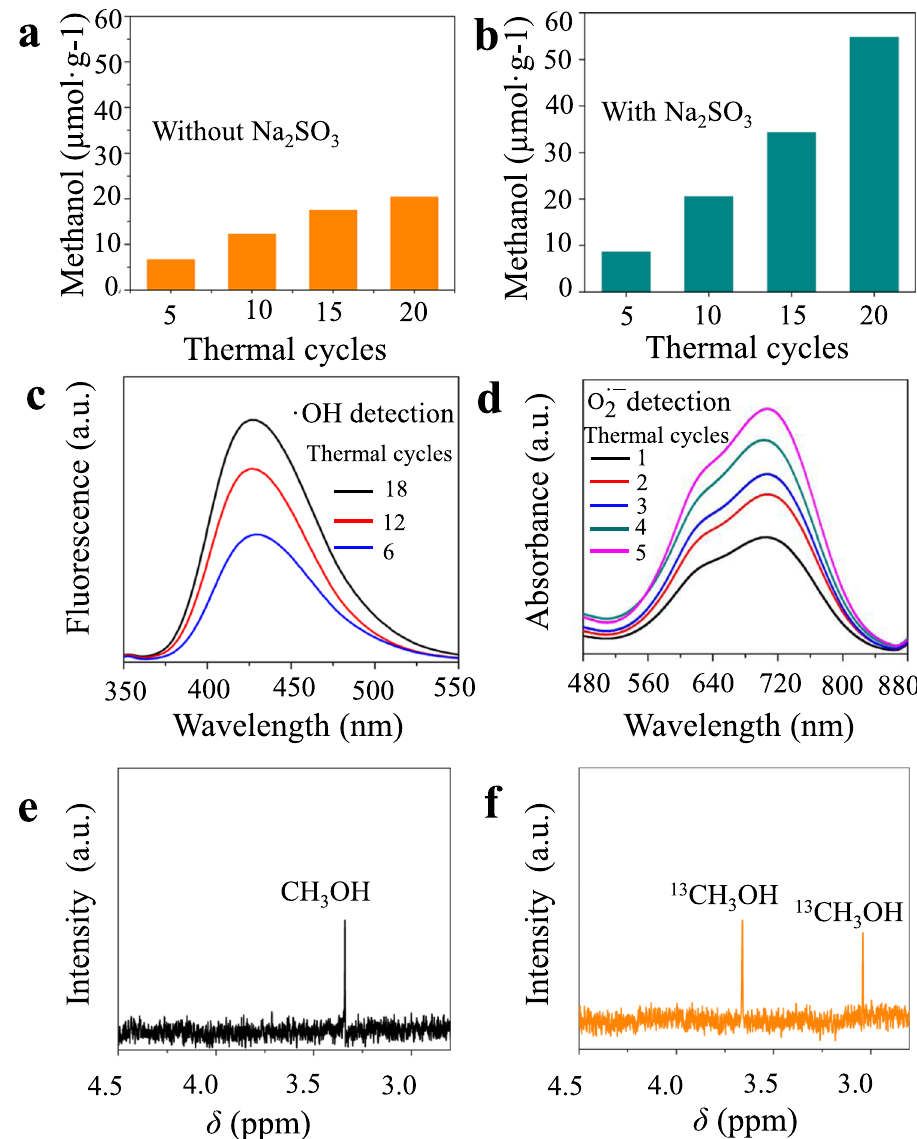
Fig. 3 Catalytic activities of Bi 2 WO 6 . a Methanol yield through pyroelectric catalytic CO 2 conversion without Na 2 SO 3 , and b with Na 2 SO 3 as sacri fi cial agent. c The fl uorescence spectra of 2-hydroxyterephthalic acid, d the absorption spectra of diformazan and monoformazan. e 1H NMR spectra of the pyroelectric catalytic reaction solution with unlabeled CO 2 and f 1H NMR spectra of the pyroelectric catalytic reaction solution with labeled 13 CO 2